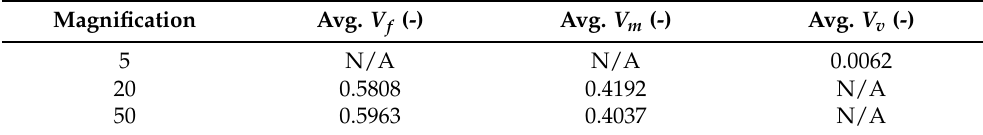
Table 1. Average volume fractions for fiber ( V f ), matrix ( V m ), and void ( V v ) of the manufactured plate.